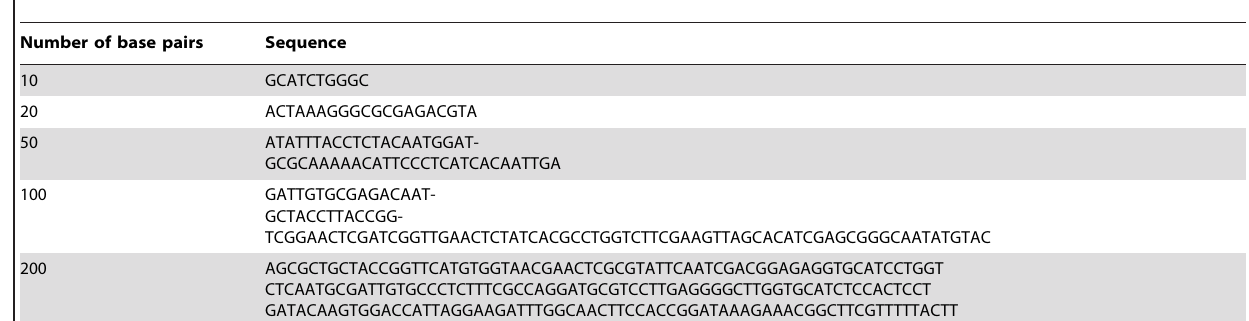
Table 1. DNA Duplex